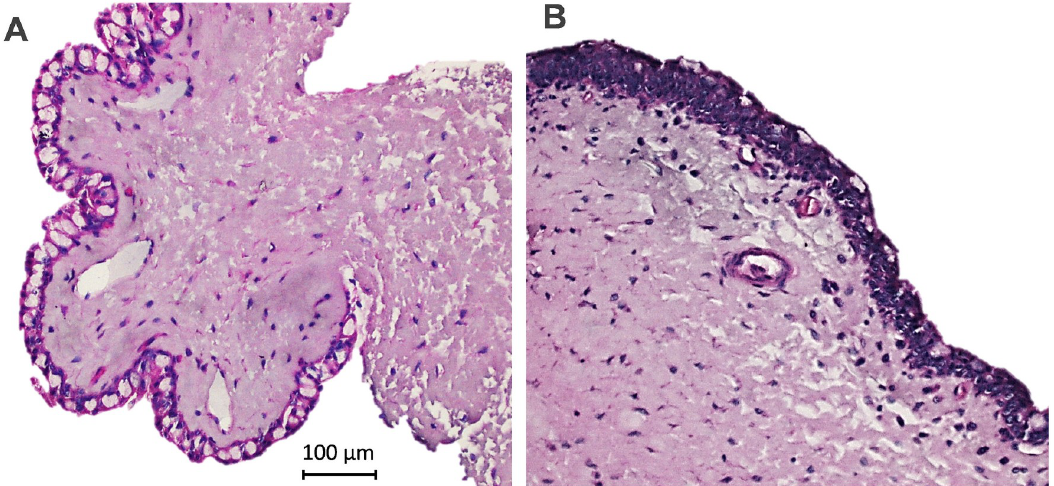
Fig 1. DED histopathology of the rabbit. Cross tissue sections of superior bulbar conjunctiva on day 18 from NZW rabbits (H&E stain). Representative images from na ï ve (A) and rabbis with DED (B), with the latter showing disrupted architecture (increased stratification, goblet cell loss, and chronic inflammatory infiltrate) not present in the normal tissue. Scale bar = 100 μ m.